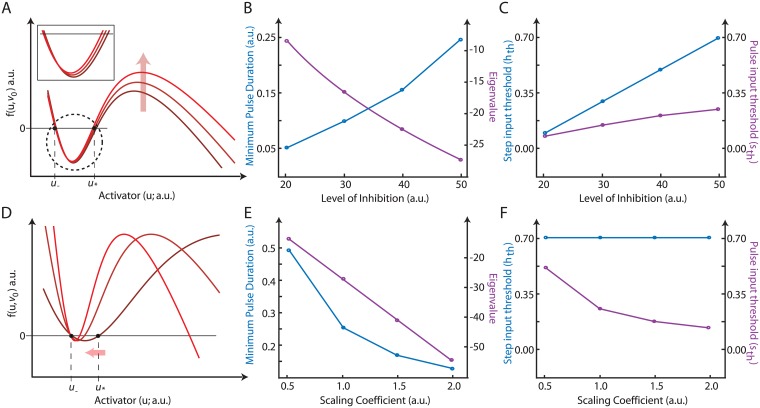
Modulating the minimum pulse duration.A. The bistable nullcline (f(u, v0)) plotted as a function of the state u (green curve), with increasing initial inhibition (v0) levels as indicated by the arrow. A zoomed in version of the critical region is shown in the box in order to highlight the raising of the nullclines. B. (blue) Graph plotting the minimum pulse duration needed to elicit a full response with increasing levels of inhibition. (purple) Location of eigenvalue corresponding to the new equilibrium state with each level of inhibition. Only one pertinent eigenvalue is shown. C. Graph plotting how the step (blue) and pulse (purple) input thresholds changed with altering level of inhibition. D. The bistable nullcline (f(ku, kv0)) plotted against u with increasing values of k causing a contraction of the nullcline as indicated by the red arrow (dark red: k = 0.5, lighter red: k = 1, light red: k = 1.5). E. (blue) Plot showing the minimum pulse duration needed to elicit a full response with increasing scaling coefficient k. (purple) Location of the eigenvalue corresponding to the new equilibrium state with each k. F. Graph plotting how the step (blue) and pulse (purple) input thresholds changed with altering scaling coefficient.